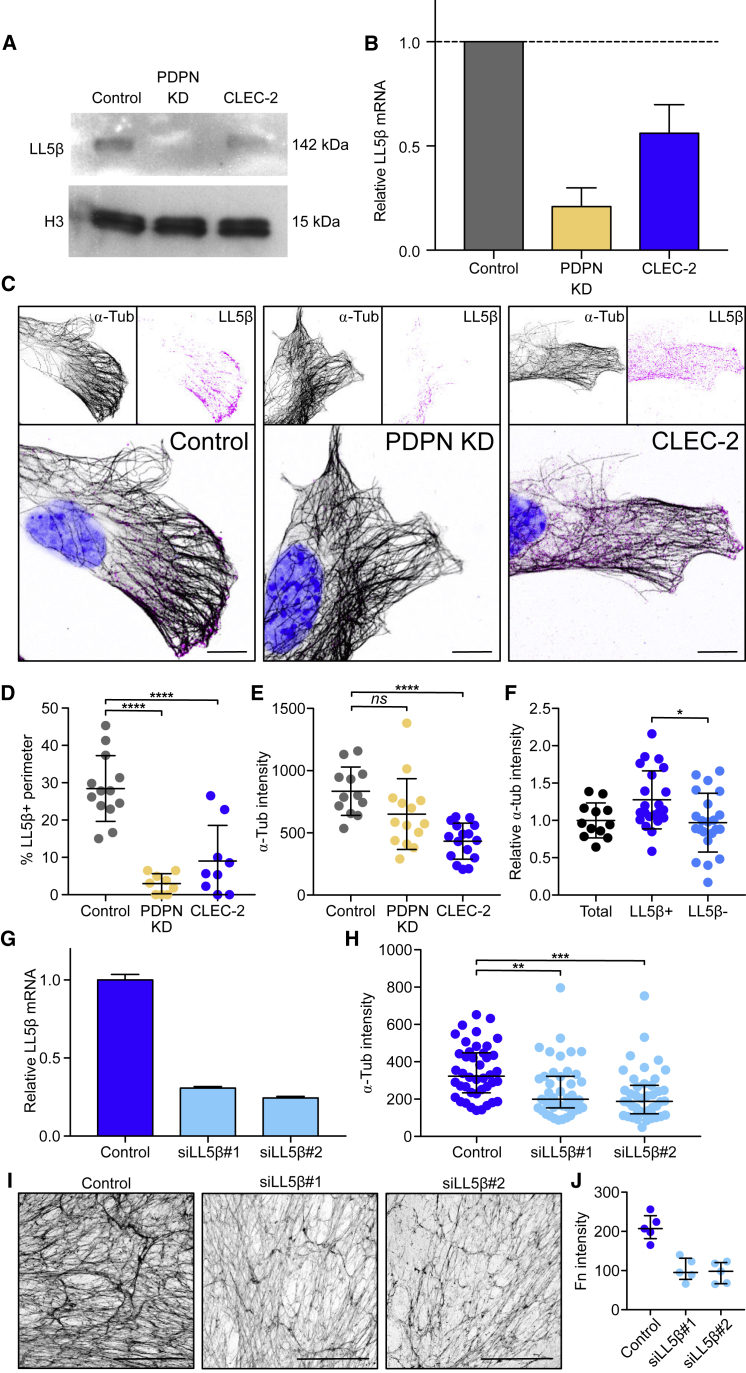
Regulation of Microtubule Organization by CLEC-2 via LL5β(A) Representative western blots showing LL5β expression in FRC cell lines.(B) Expression of LL5β mRNA relative to control FRCs by qPCR. Error bars represent means and SDs of 2 biological replicates.(C) Immunofluorescence of FRC cell lines in vitro. Maximum z stack projections. Scale bars, 10 μm.(D) Quantification of LL5β coverage in FRC cell lines as a percentage of the total perimeter. Each dot represents 1 cell. Error bars represent means and SDs. ∗∗∗∗p < 0.00005, one-way ANOVA, Tukey’s multiple comparisons test.(E) α-Tubulin intensity in the cortical area (10 μm from the edge) of FRC cell lines. Each dot represents 1 cell. Error bars represent means and SDs. ∗∗∗∗p < 0.00005, one-way ANOVA, Tukey’s multiple comparisons test. NS, not significant.(F) α-Tubulin intensity in the cortical area (10 μm from the edge) in LL5β+ and negative areas in control FRCs relative to the total area. Black dots represent cells and blue dots represent cell areas. Error bars represent means and SDs. ∗p < 0.05, one-way ANOVA, Tukey’s multiple comparisons test.(G) Expression of LL5β mRNA by qPCR in LL5β siRNA transfected FRCs (n = 2). Error bars represent means and SDs.(H) αTubulin intensity in the cortical area (10 μm from the edge). Each dot represents 1 cell. Error bars represent means and SDs. ∗∗p < 0.005, ∗∗∗p < 0.0005, one-way ANOVA, Tukey’s multiple comparisons test.(I) Representative in vitro cell-derived matrices from LL5β KD FRCs, decellularized and stained for fibronectin. Maximum z stack projections. Scale bars, 100 μm.(J) Median gray intensity for fibronectin staining. Each dot represents a different region of interest, from 2 biological replicates. Error bars represent means and SDs.